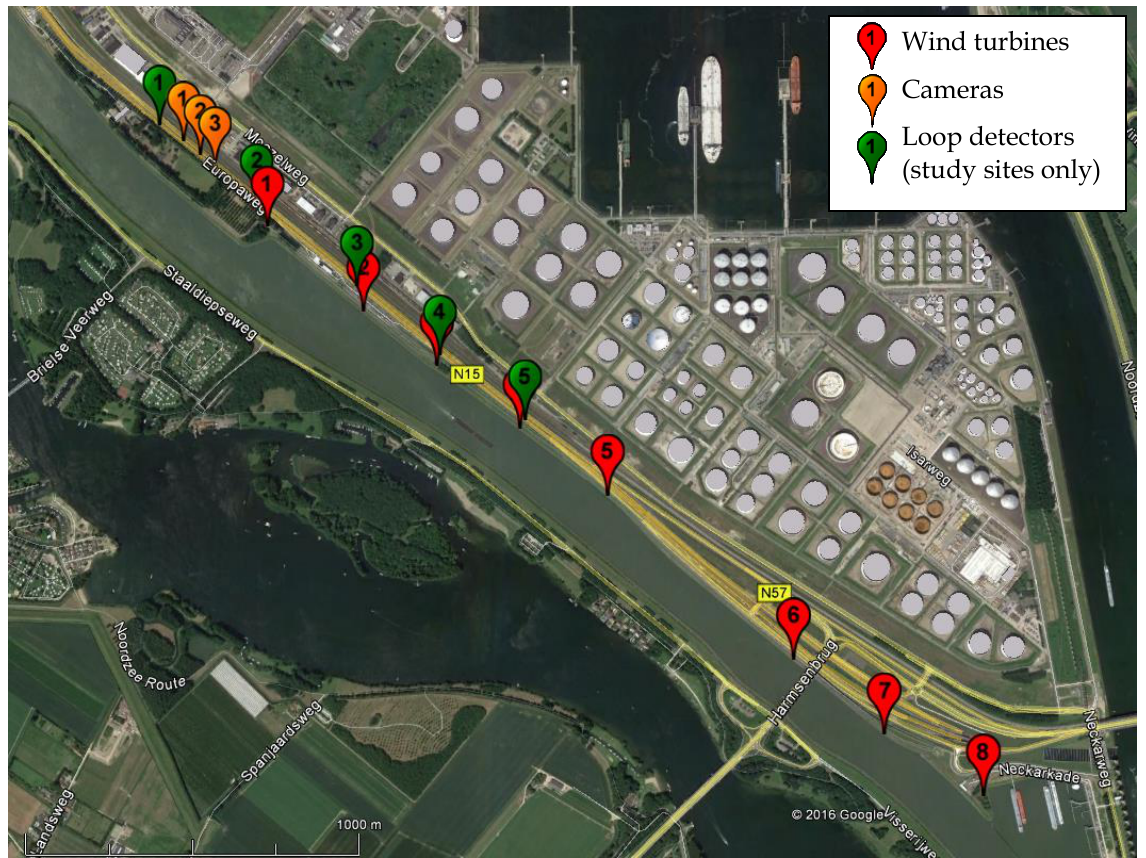
Figure 1. Research location. Positions of wind turbines, temporary cameras and loop detectors (study sites only) are indicated (image adopted from Google Earth).